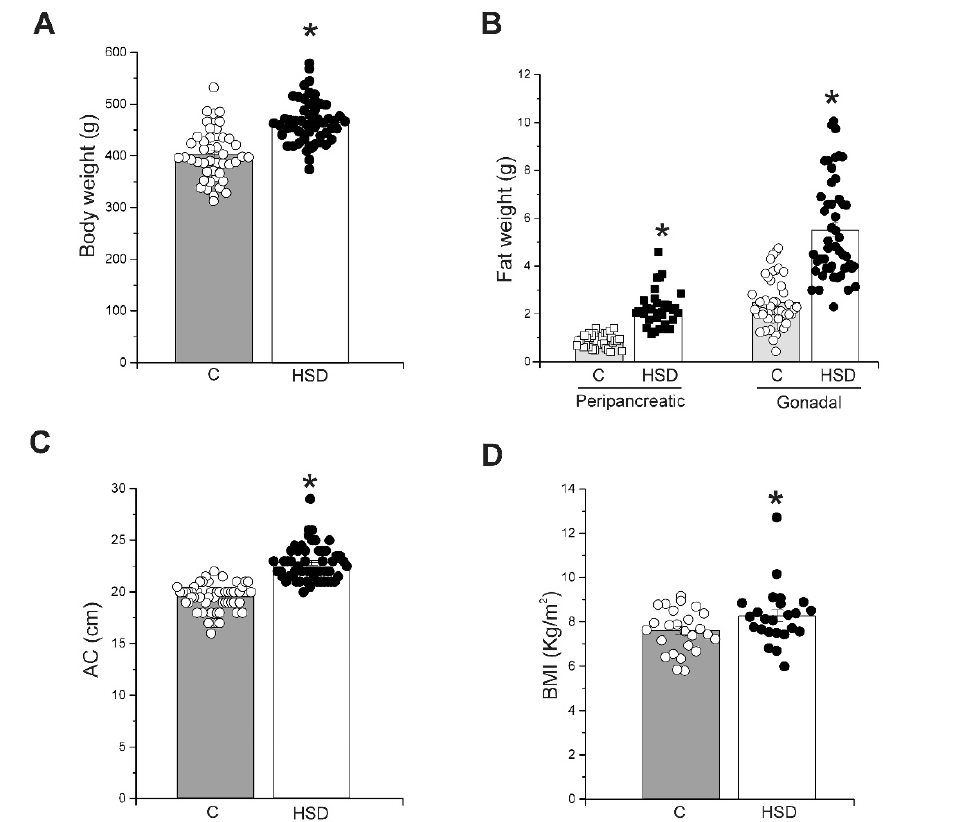
Figure 1. High-sucrose diet induces obesity. ( A ) Body weight gain after 8 weeks on HSD. Bars represent the mean ± SE and each circle or square represents individual data from control ( n = 46) and HSD rats ( n = 46). * p ≤ 0.0001 compared to the control group. ( B ) Peripancreatic and epididymal fat from control group (grey bars, n = 46) and HSD group (white bars, n = 46). Bars represent the mean ± SE and each circle or square represents individual data. * p ≤ 0.0001 compared to the control group. ( C ) Abdominal circumference (AC) of control and HSD groups. Bars represent the mean ± SE and each circle or square represents individual data. * p ≤ 0.0001 compared to control group. ( D ) Body mass index (BMI) of control and HSD groups. Bars represent the mean ± SE and each circle or square represents individual data. * p ≤ 0.0001 compared to control